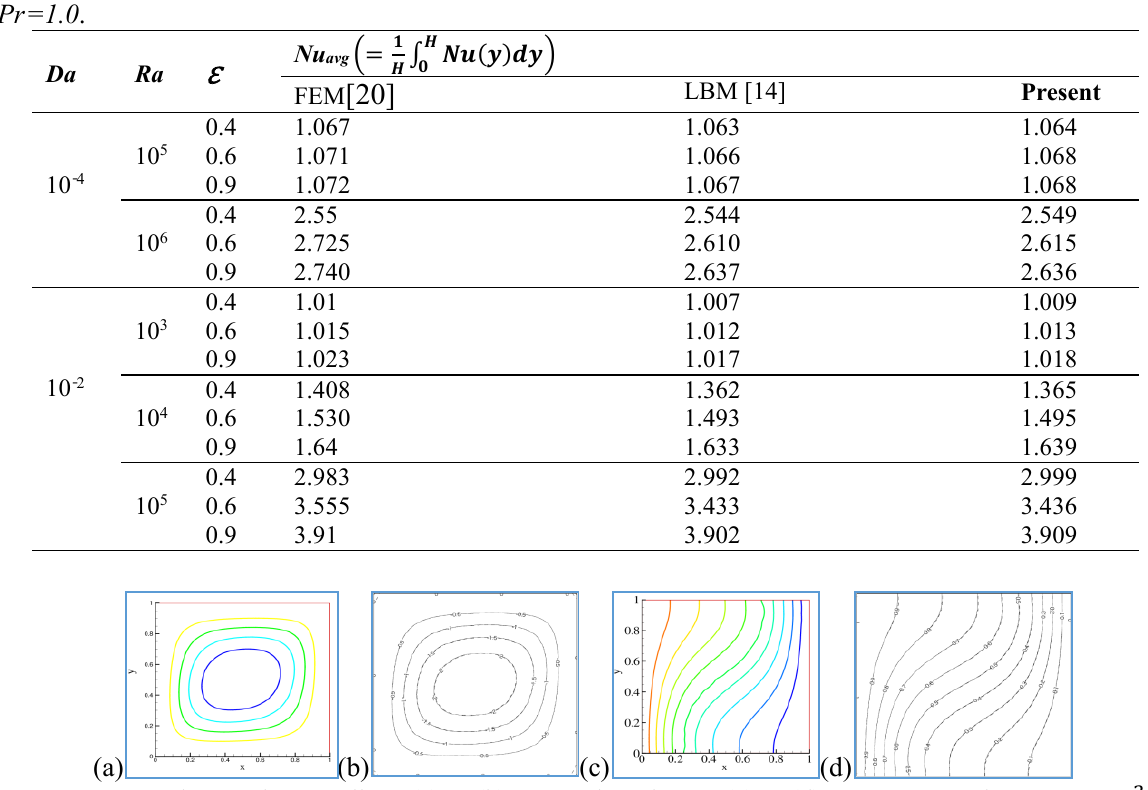
Fig. 3. Comparisons of Streamlines (a) & (b) [14] and Isotherms (c) & (d) [14] contours for 𝐷𝑎 = 10 −2 , 𝑅𝑎 = 10 4 , and 𝜀 = 0.6